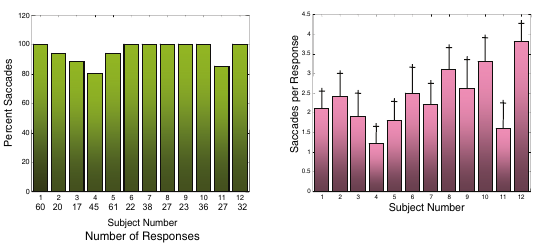
Figure 5 A) Percentage of responses that contain saccades for all 12 subjects. In more than half of our subjects, at least one saccade was found in all responses to pure vergence step stimulus. The number of responses analyzed for each subject is shown below the subject number. B) Saccades per response for our 12 subjects. The number of saccades varies from just over 1 to around 4 saccades per response. The error bars indicate 1 standard deviation.